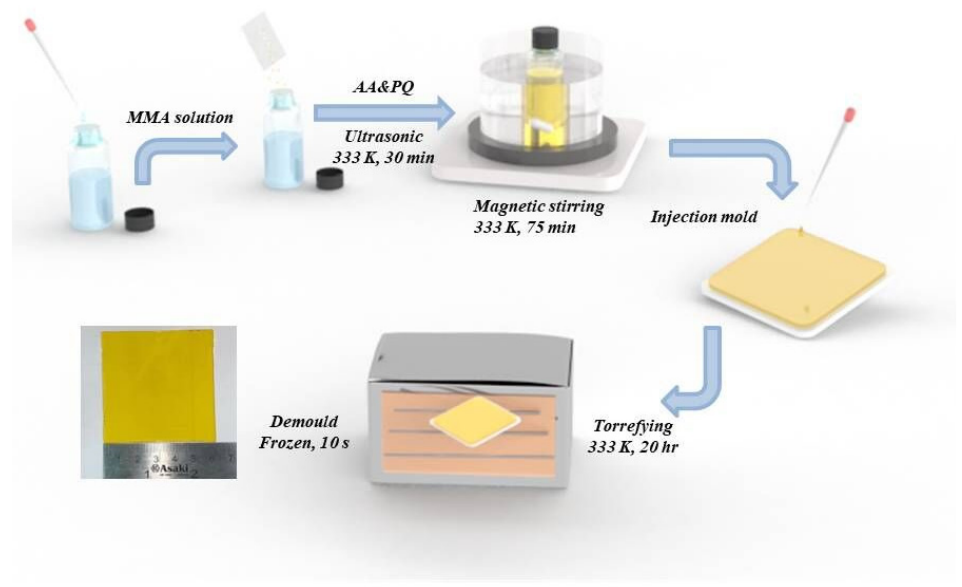
Figure 6. Schematic synthesis strategy of PQ/PMMA photopolymer materials.